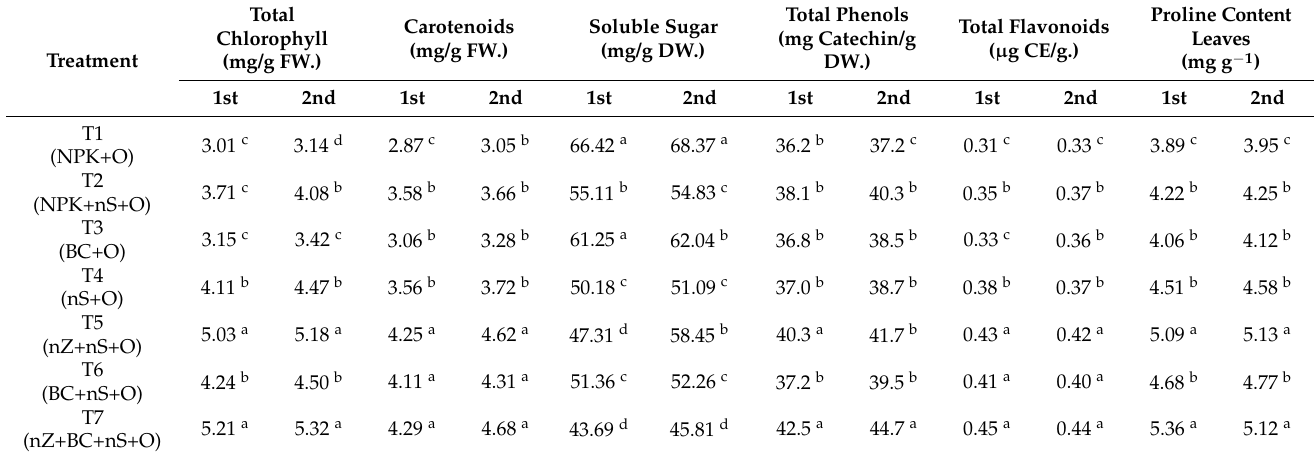
Table 7. Effect of nanoparticles on photosynthetic pigments and biochemical contents of thyme plant during 2020 and 2021 growing